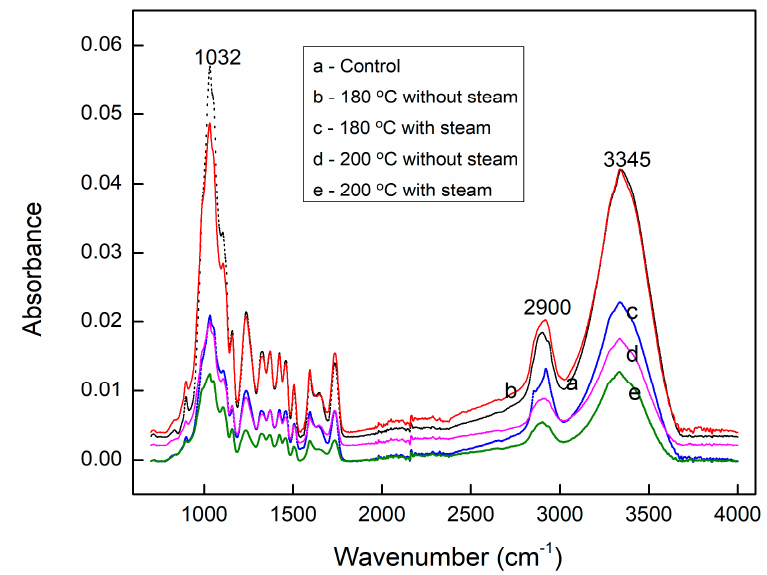
Figure 3. Typical ATR-FTIR spectra for the control and densified sugar maple wood samples.